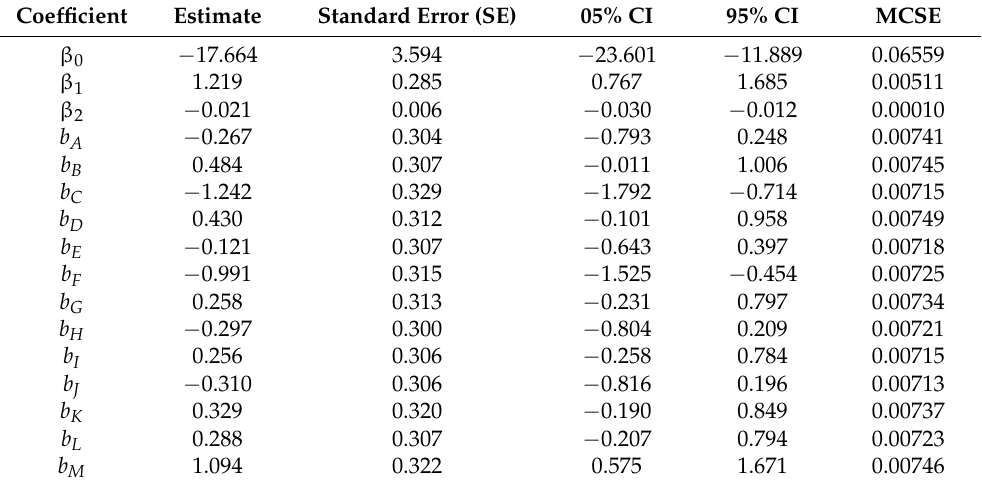
Table 4. Complete report of the quadratic GLMM coefficients. The estimate for each coefficient is provided along with measures of uncertainty (standard error of the mean, 90% credible intervals and the Monte Carlo standard error—estimation of the randomness associated with each MCMC run).